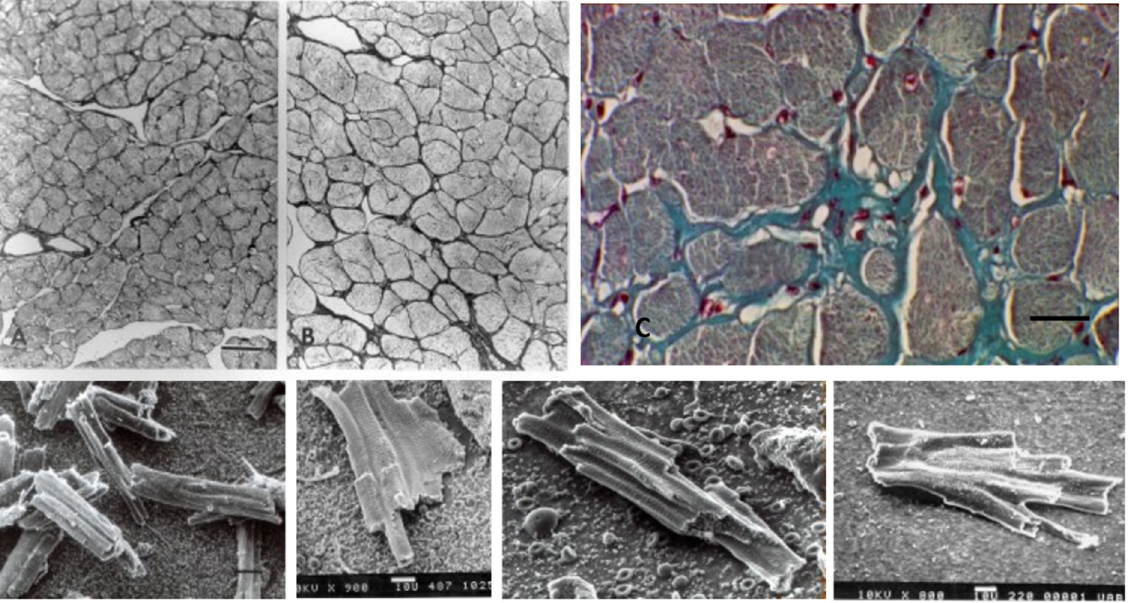
Figure 12. ( A ) Sham-operated and ( B ) 8-week aortic banded rats at same magnification. Note increased size and variable cross-sectional area in the banded rat. Methacrylate embedded, 1 µm section, silver stain. Bar = 50 µm for both A and B. ( C ) Patient with old ischemic infarct. Note marked variability in hypertrophied LV myocytes. Masson trichrome stain. Bar = 20 µm. ( Bottom row ) Scanning electron micrographs of isolated myocytes from hypertrophied LV of aortic banded rats. Note extreme variability in size and shape, grooves for capillaries.